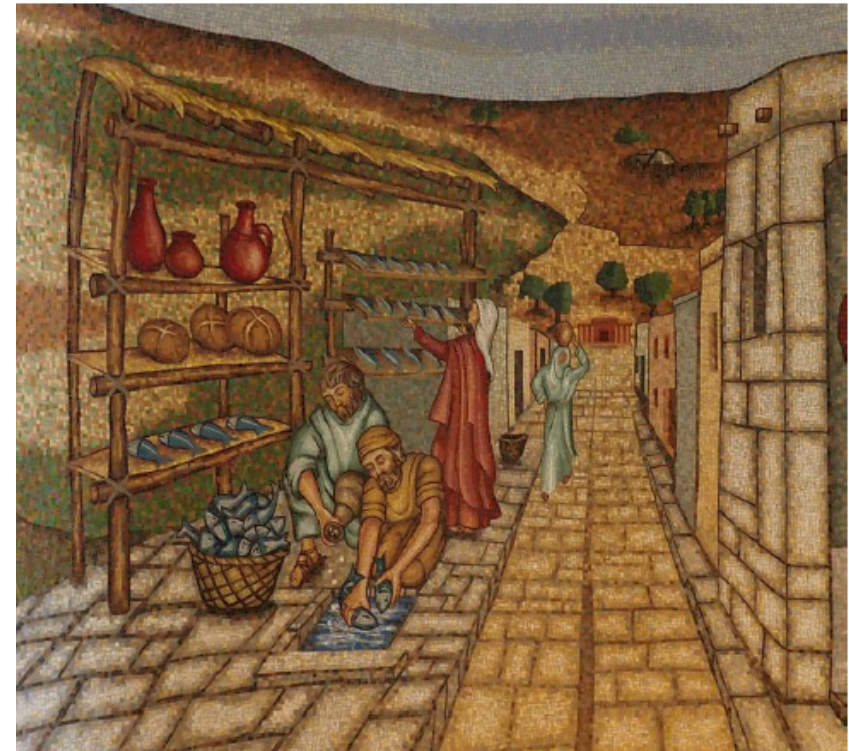
Figure 6. Detail: Market Scene.